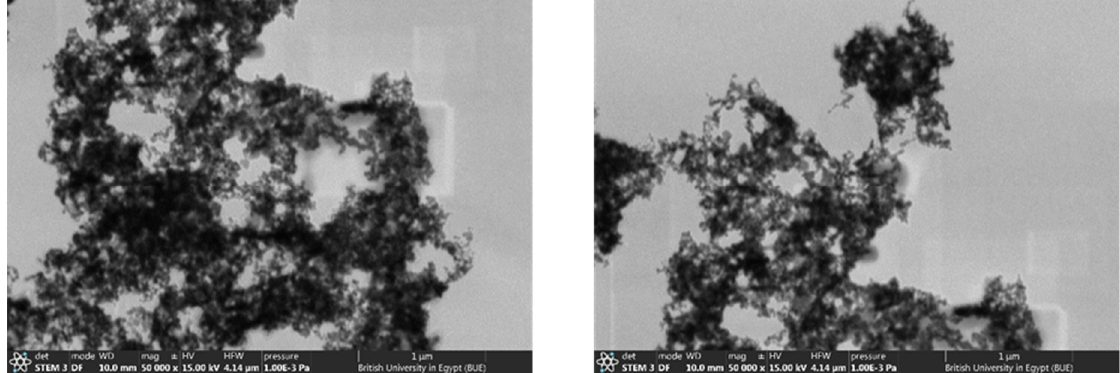
Figure 6 . The STEM micrograph of the ZnO/rGO nanocomposite. Figure 6. The STEM micrograph of the ZnO/rGO nanocomposite. Table 1. Surface area parameters obtained from BET surface area analyzer.